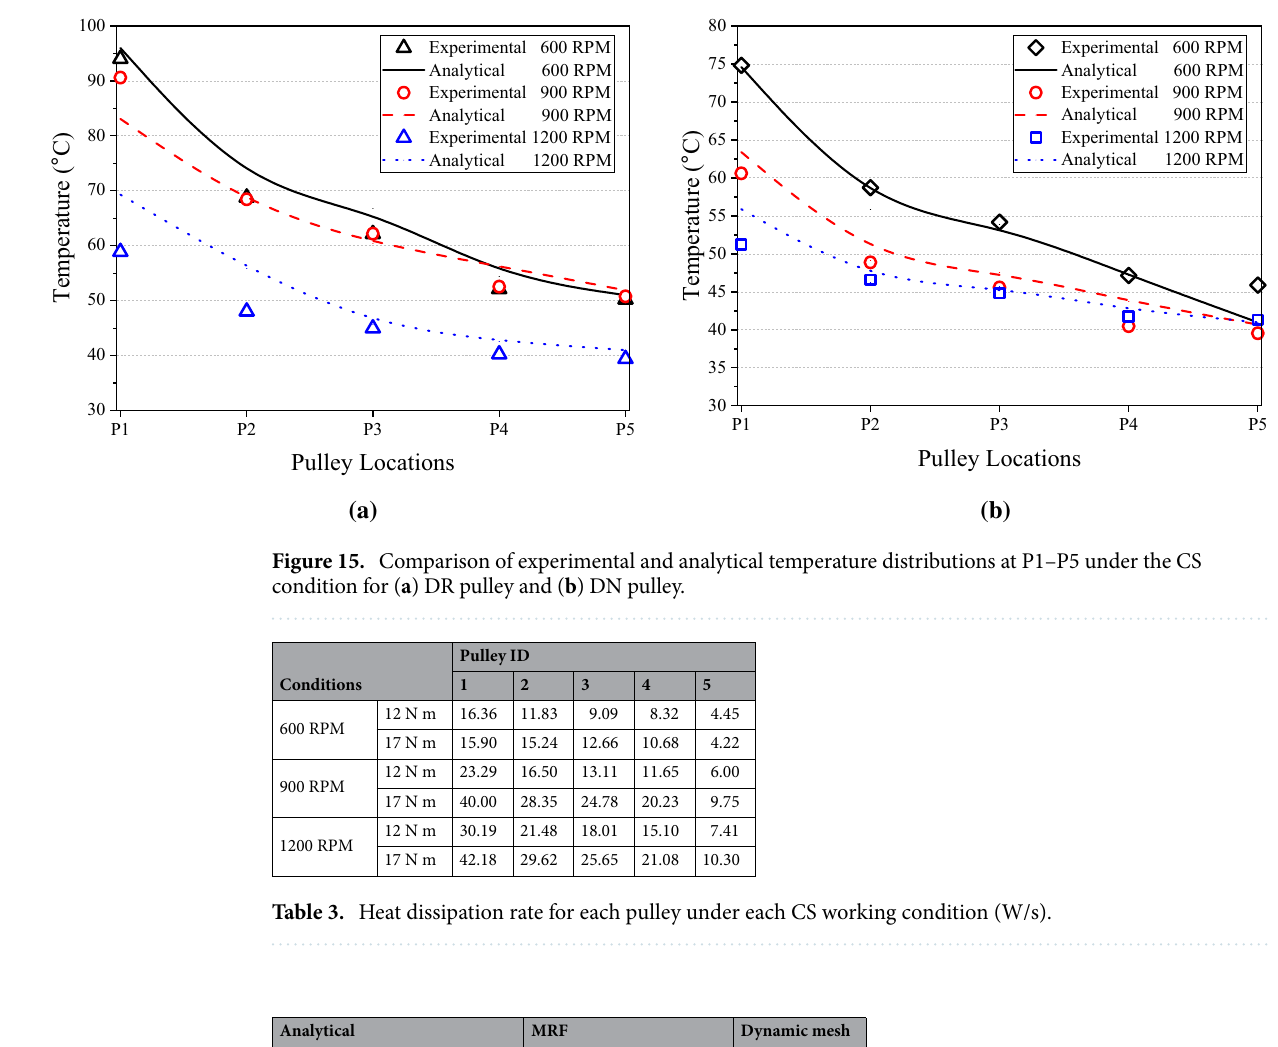
Analytical MRF Dynamic mesh 5 s 16 h Table 4. Time required by each method to predict the temperature distribution on a belt drive.